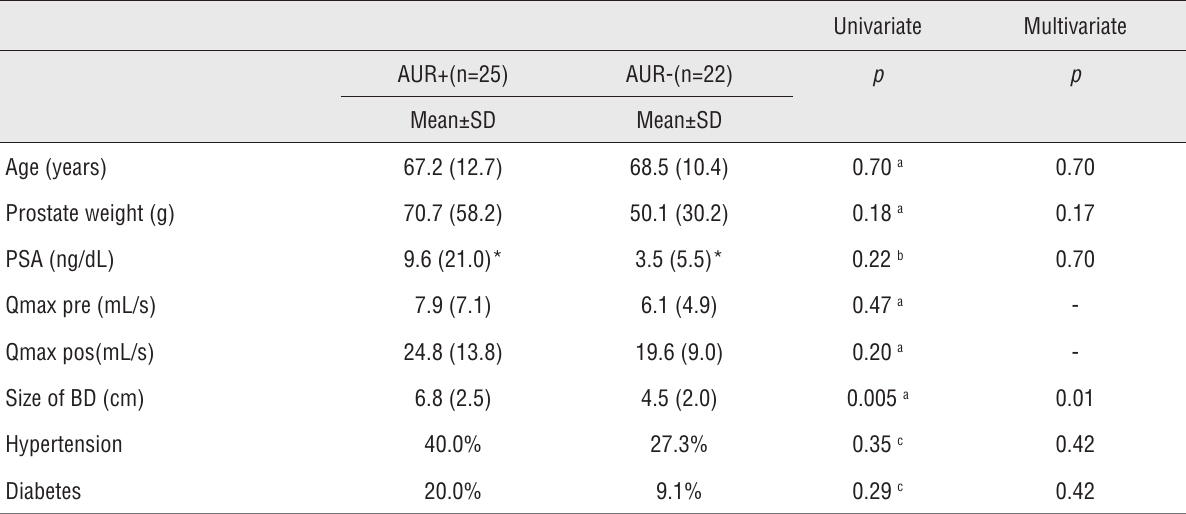
Table 1 - Data comparing patients with bladder diverticula with and without AUR.